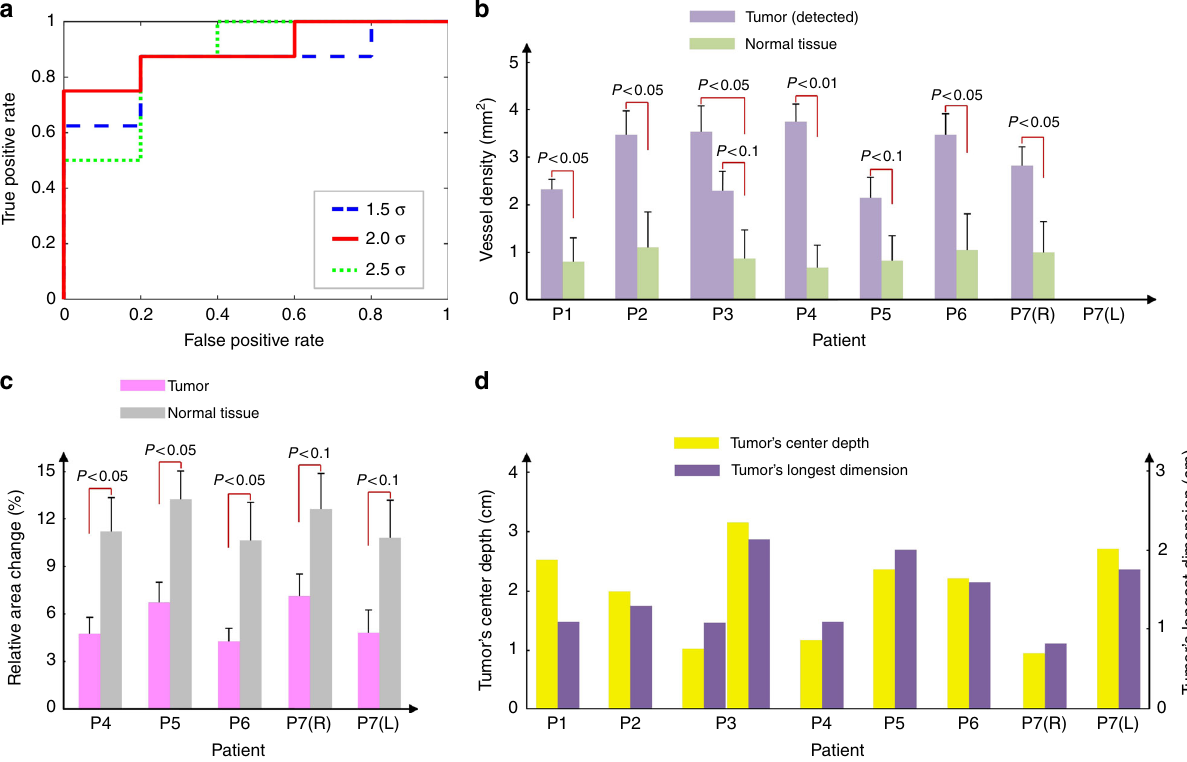
Fig. 4 Statistics. a The ROC curves of breast tumor detection based on blood vessel density. σ , standard deviation. b The average vessel density in each tumor and surrounding normal breast tissue. c The relative area change in each tumor and surrounding normal breast tissue caused by breathing. The elastographic study was started with Patient 4. d The longest dimension and center depth of each